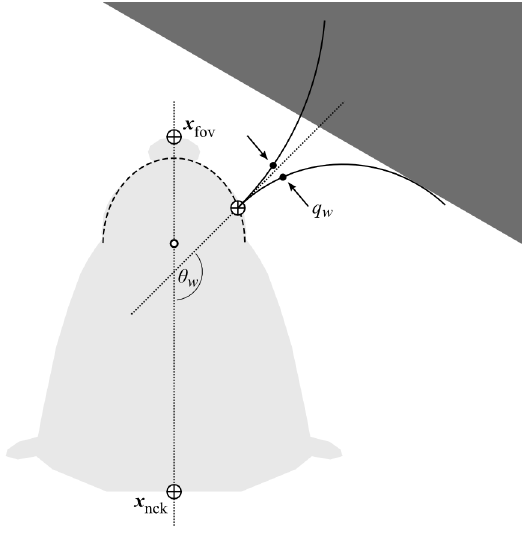
Figure 4. Plane model detail. Head (light grey) location/orientation is defined by x fov and x nck . Nearby obstacle (dark grey). Whisker base is located on ‘mystacial pad arc’ (dashed curve) which traces the snout outline (open dot marks arc center). Whisker shaft angle at the base, denoted h w , is defined with respect to head midline (dotted lines). Unperturbed whisker arc (upper solid line) intersects obstacle. Perturbed whisker arc (lower solid line) is found by adjusting curvature caudally until no intersection occurs. Deviation of point marked with solid dot from unperturbed to perturbed arc is denoted q w .